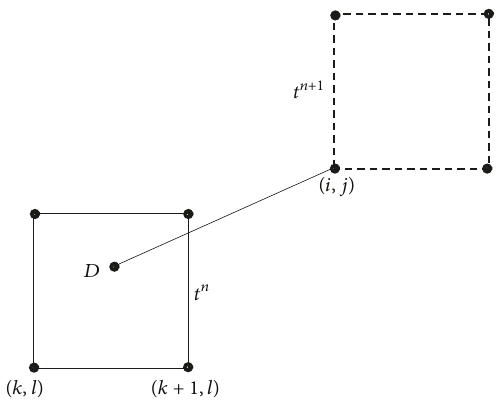
Figure 1: The process of constructing characteristic finite difference